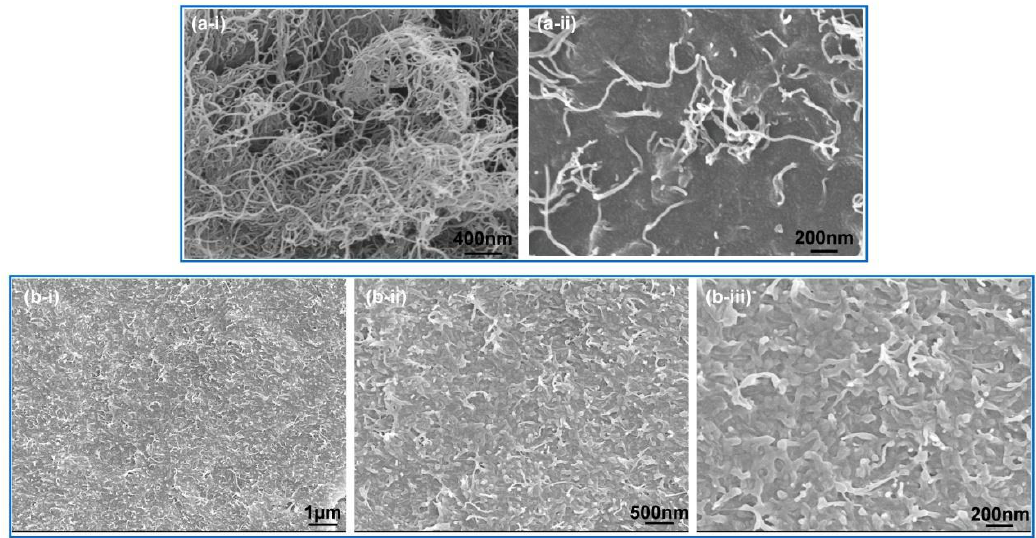
Figure 3. The morphology of MWCNTs ( a ) and the antistatic PA1012 master batch (M = 15 wt%) ( b ).